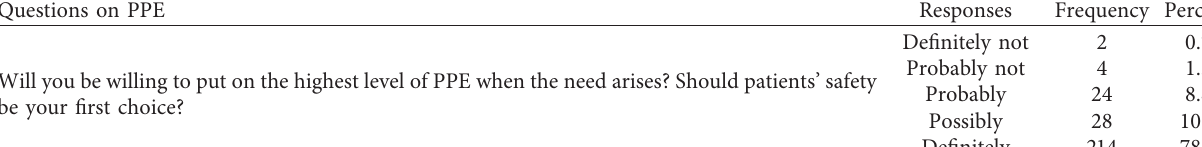
Table 8: Attitudes and beliefs of health workers towards the use of